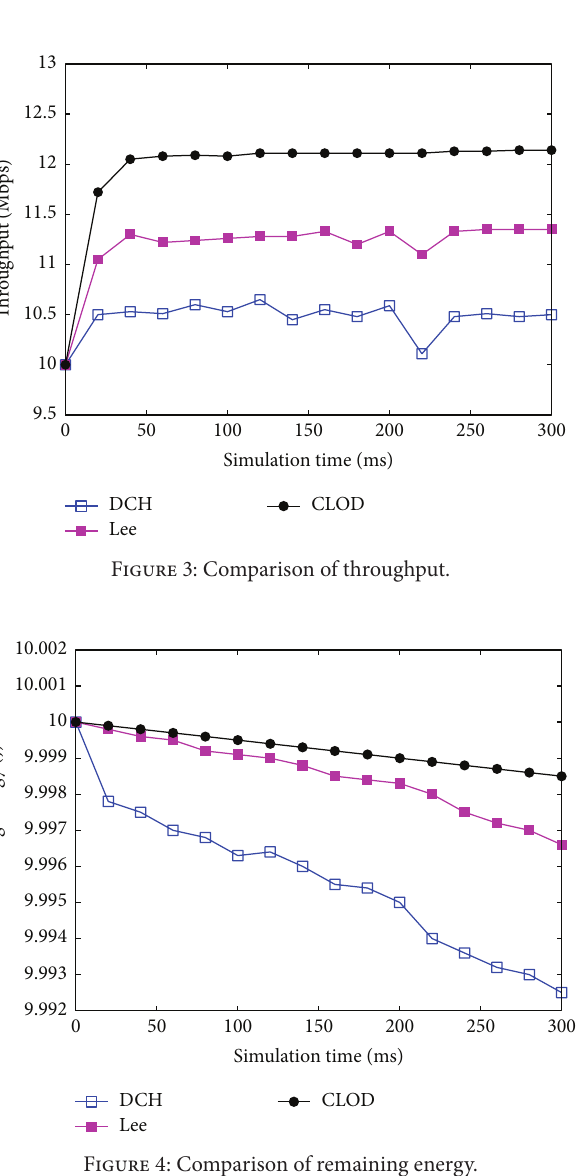
Figure 4: Comparison of remaining